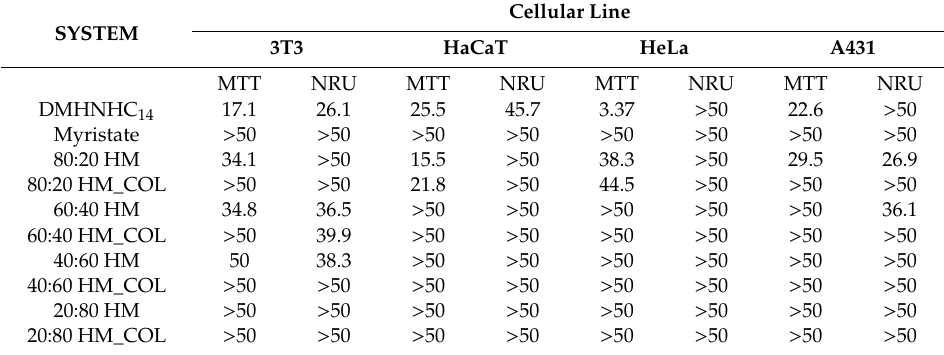
Table 5. IC 50 ( µ M) of the pure DMHNHC 14 , sodium myristate and their catanionic mixtures against the di ff erent cell lines studied in this